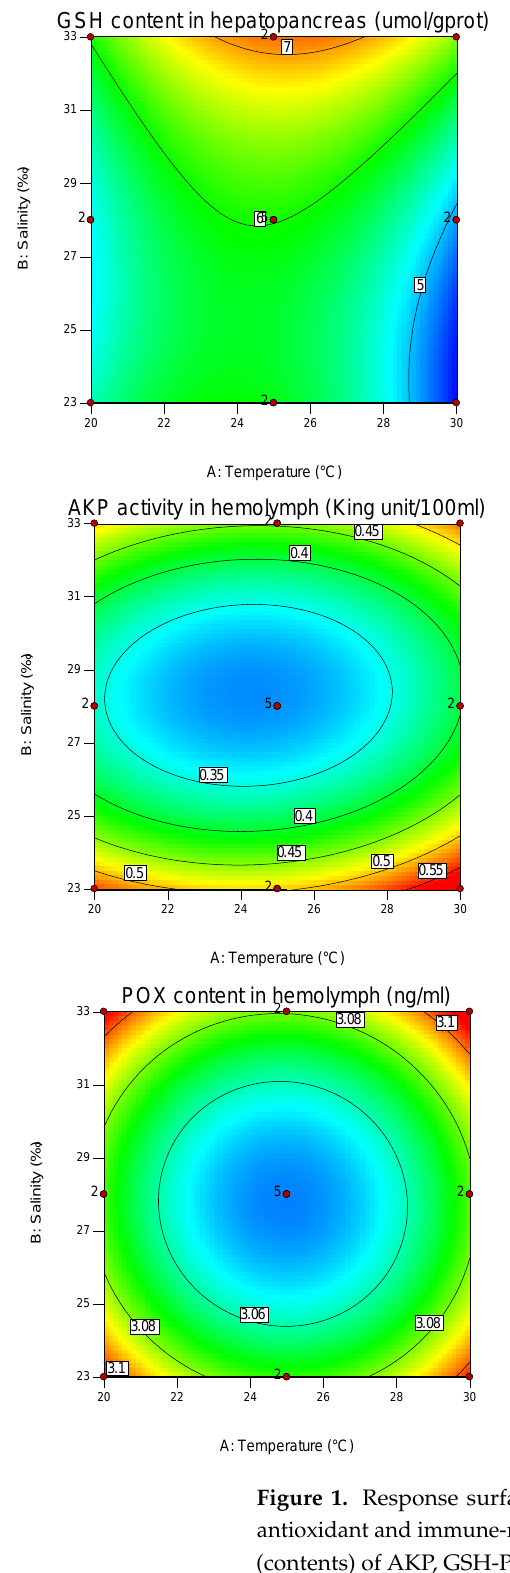
Figure 2. By examining the response surface or contour, the expression of the SOD gene